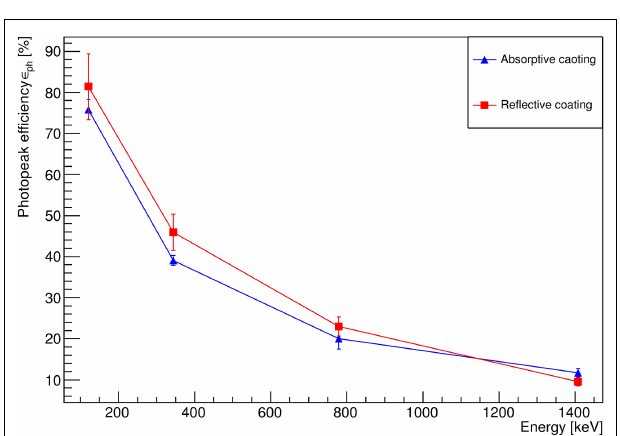
FIGURE 4 | Photopeak detection efficiency of the absorptively (blue) and reflectively (red) wrapped LaBr 3 :Ce crystal using a 152 Eu calibration source . Background, solid angle, and DAQ dead time corrections were applied to these data. The solid lines are to guide the eye.